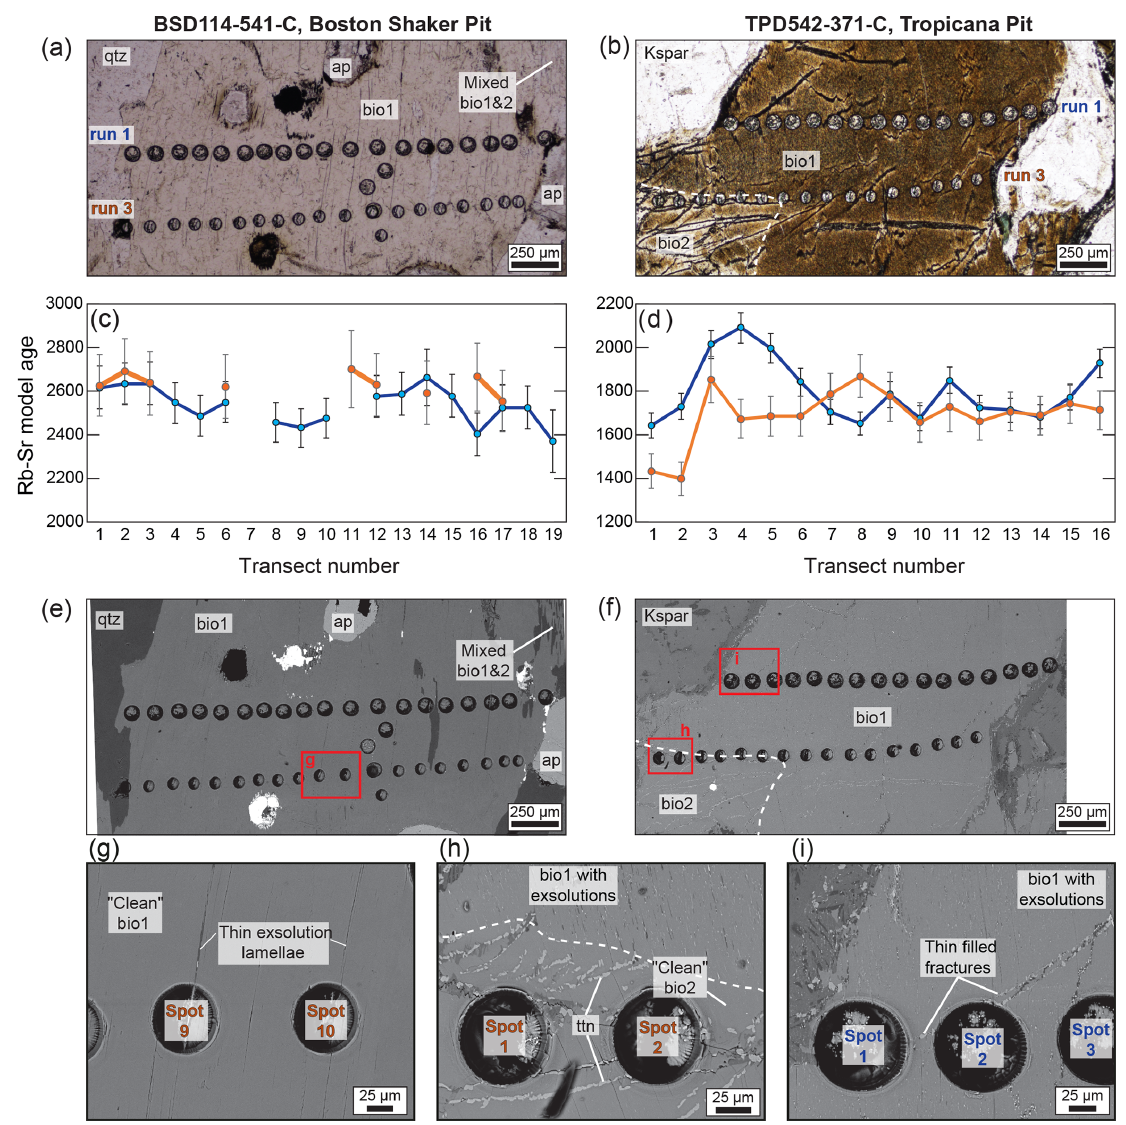
Figure 7. Transects across two large, euhedral biotite grains. (a, b) Transmitted, plane-polarized photomicrographs of part of the euhedral grains, showing 87µm (run 1) and 64µm (run 3) laser ablation pits along the grains. (c, d) Rb–Sr model ages for each spot in the transect across two runs. Model ages were computed using 87 Sr / 86 Sr of apatite 1 in the corresponding sample (see Fig. 9). (e, f) Backscattered electron images of the same regions as (a) and (b) . (g) Zoomed-in region showing inclusion-free biotite 1 in BSD114-541-C, similar to Fig. 4a and b. (h–i) Zoomed-in regions showing exsolution lamellae and fractures (commonly titanite-filled), with these fracture zones contributing to yielding younger Rb–Sr model ages. Spot numbers and colors refer back to panels (c) and (d) . The abbreviations used in the figure are as follows: ap – apatite; bio1 – euhedral, first generation biotite; bio2 – recrystallized biotite 1; Kspar – K-feldspar; qtz –